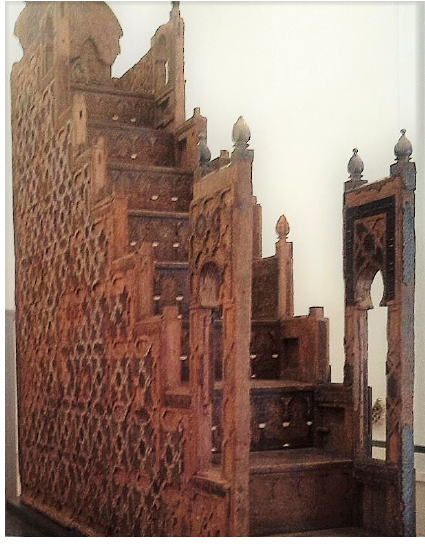
Figure 3. Minbar of the Kutubiyya mosque (Al-Badi Palace, Marrakech). Photo took by author.